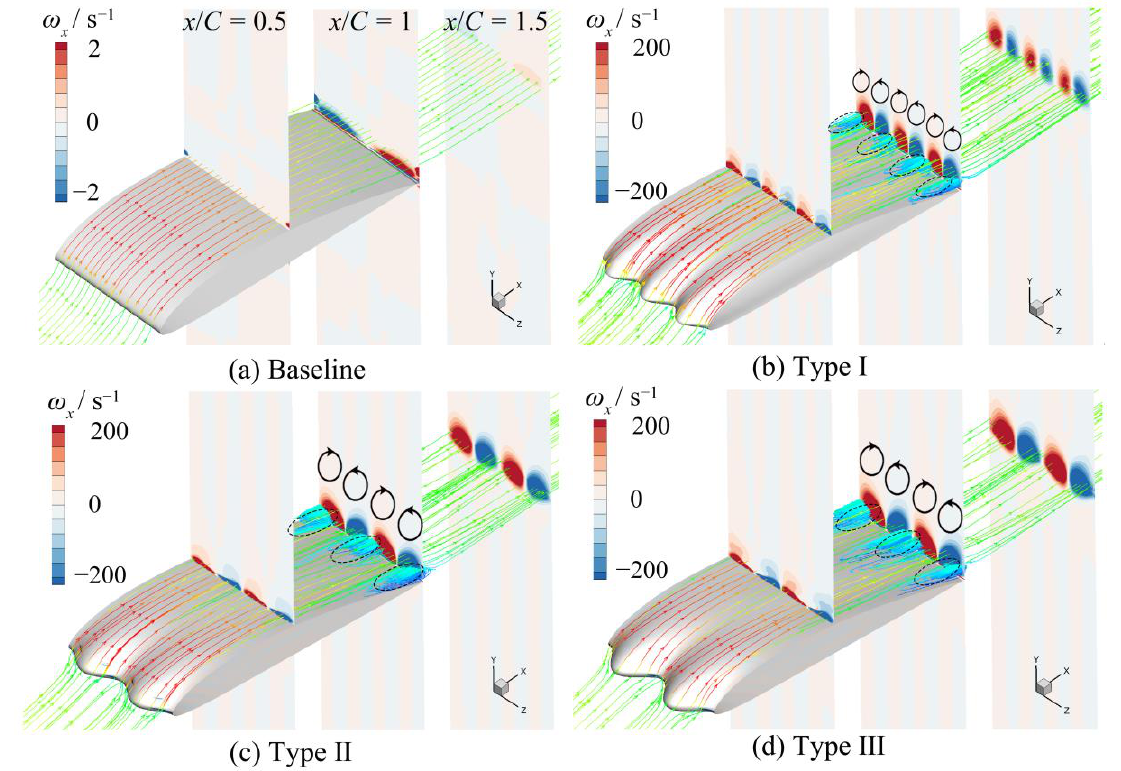
Figure 7. 3D streamlines and streamwise vortices at AOA = 8 ◦ : ( a ) Baseline, ( b – d ) Type